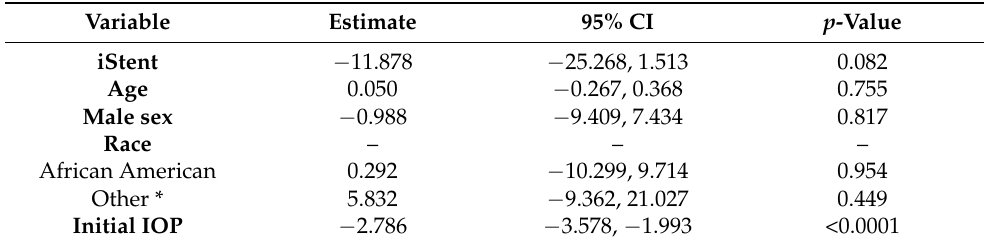
Table 3. Univariate analysis for association with percent reduction in IOP 6 months post-SLT.